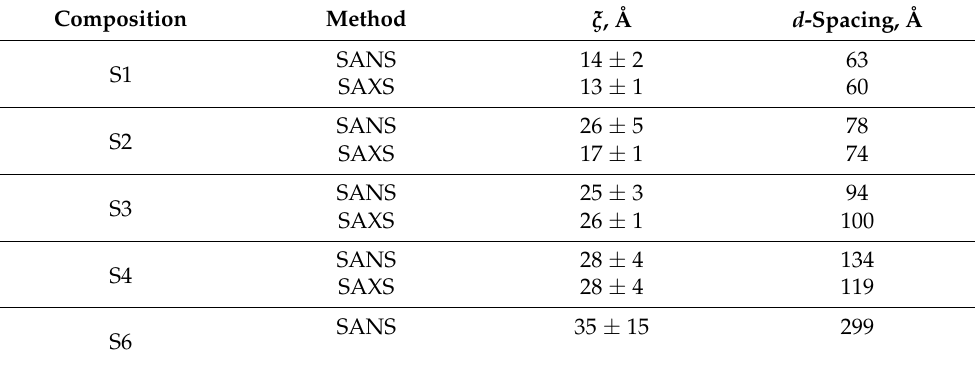
Table 4. Structural parameters of segmented PUU determined by the SANS and SAXS methods.